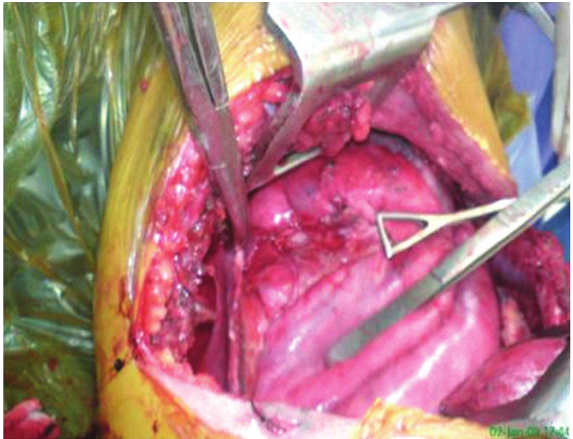
Figure 4: Left lung after decortications with leaking bronchial openings in floor of left upper lobe which were